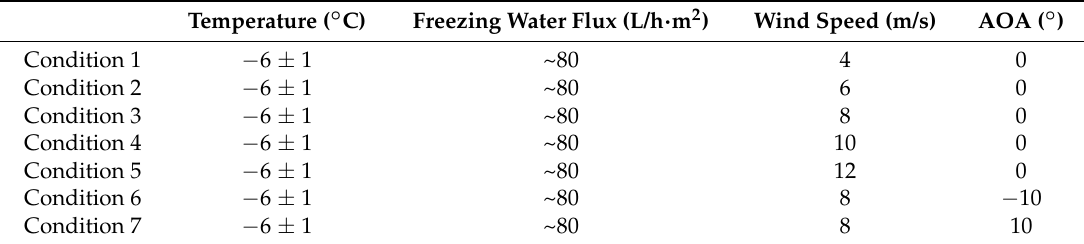
Table 2. Icing conditions for ice-accumulation tests on wind blade samples. AOA = angle of attack.